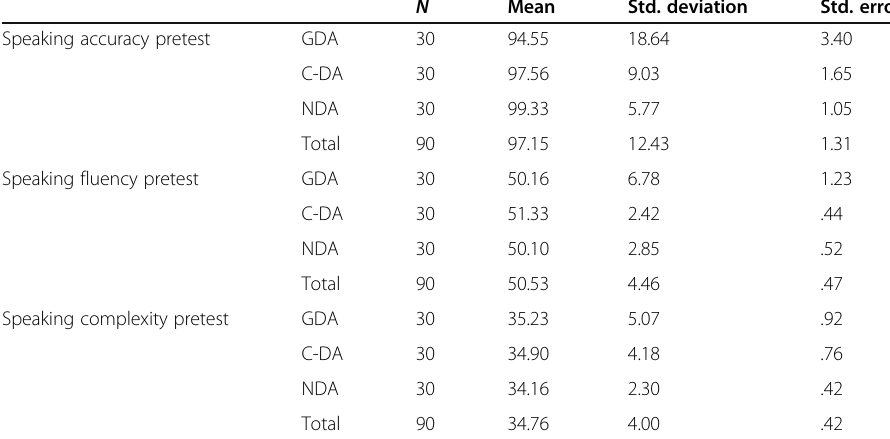
Table 1 Descriptive statistics of the speaking CAF pretest scores of GDA, C-DA, and NDA N Mean Std.